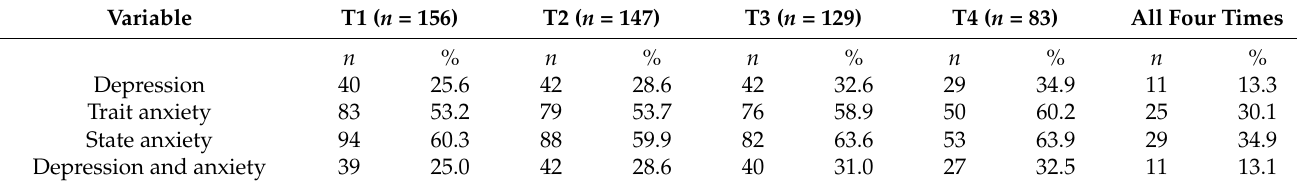
Table 3. Prevalence of anxiety and depression from pregnancy to